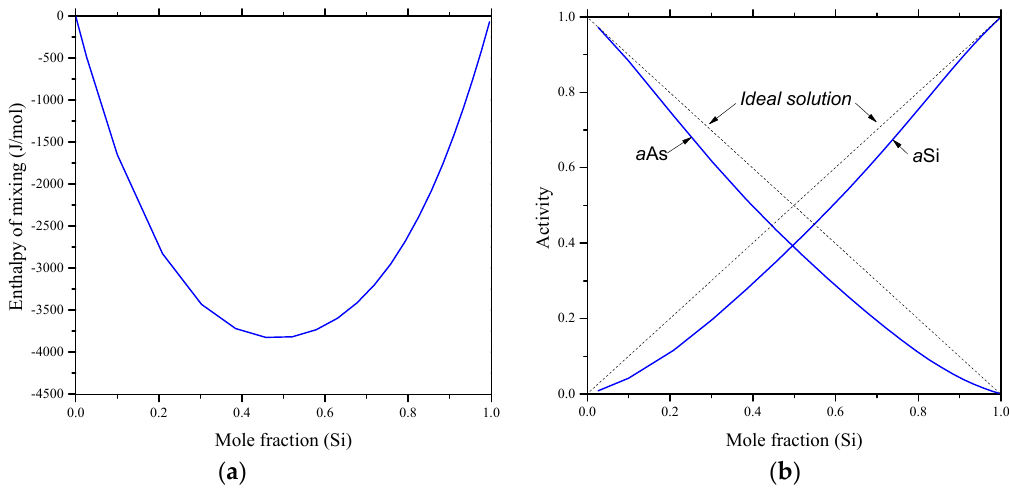
Figure 9. ( a ) Enthalpy of mixing of the As-Si liquid and ( b ) activity of As and Si in the As-Si liquid calculated in this work at 1600 °C using FactSage ® software [124]. Table 6. The enthalpy and entropy of formation of the As-Si intermetallic compounds (at 298 K and 1 atmospheric pressure).